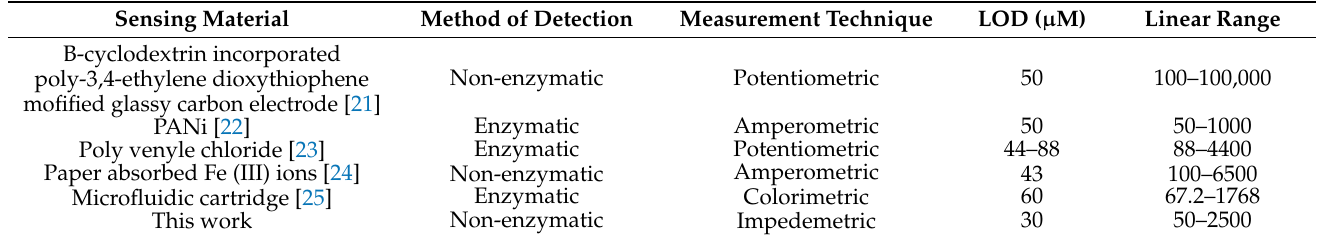
Table 1. Comparison of ZIF-8 NPs based creatinine sensor with other existing creatinine sensors.